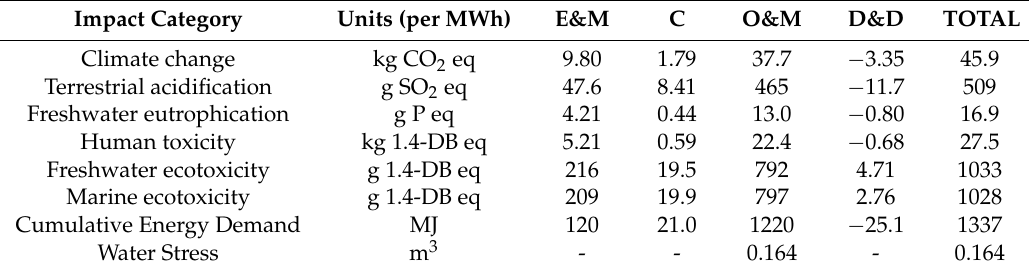
Table 2. Characterized impacts of the reference plant (reference HYSOL plant) per impact category and life